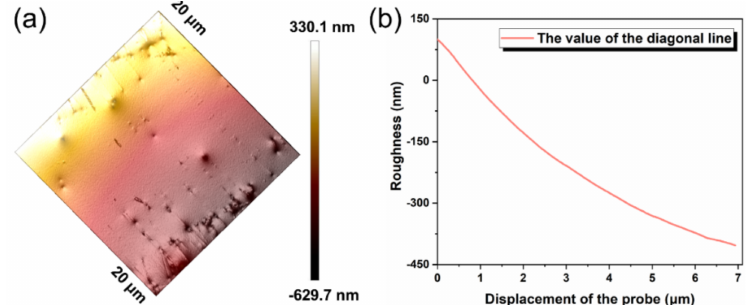
Figure 6. The 3D surface roughness of the composite film. ( a ) The plane roughness recorded by AFM. ( b ) The roughness value along the diagonal line.